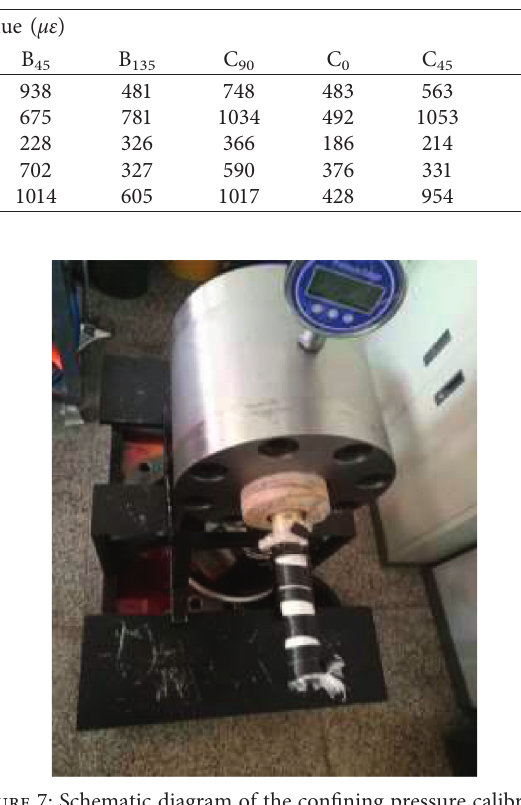
Table 4: Final strain values of each measuring point used to calculate in situ stress.